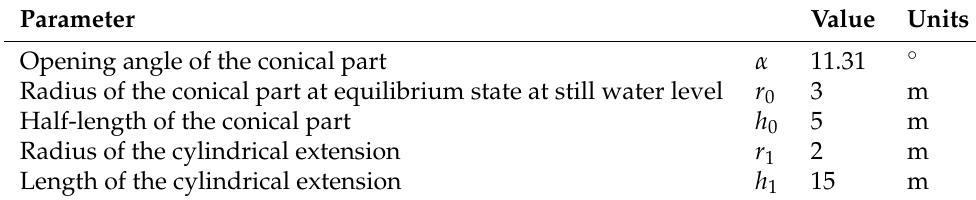
Table 1. Parameters of the test case